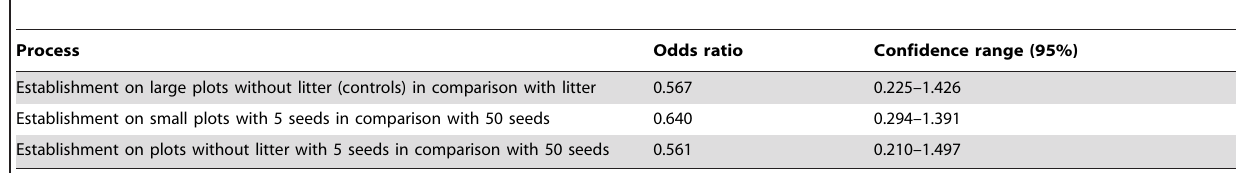
Table 3. Odds ratio and 95% confidence range based on 2 6 2 contingency tables for three processes concerning the successful establishment of